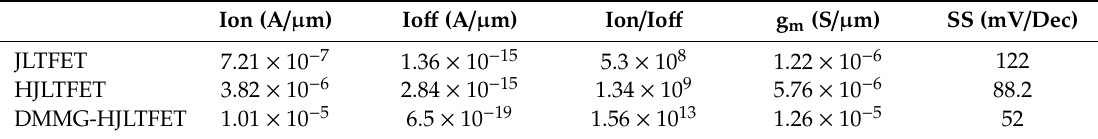
Table 2. Comparison of parameters of JLTFET, HJLTFET and DMMG-HJLTFET. Ion(A/ μ m)